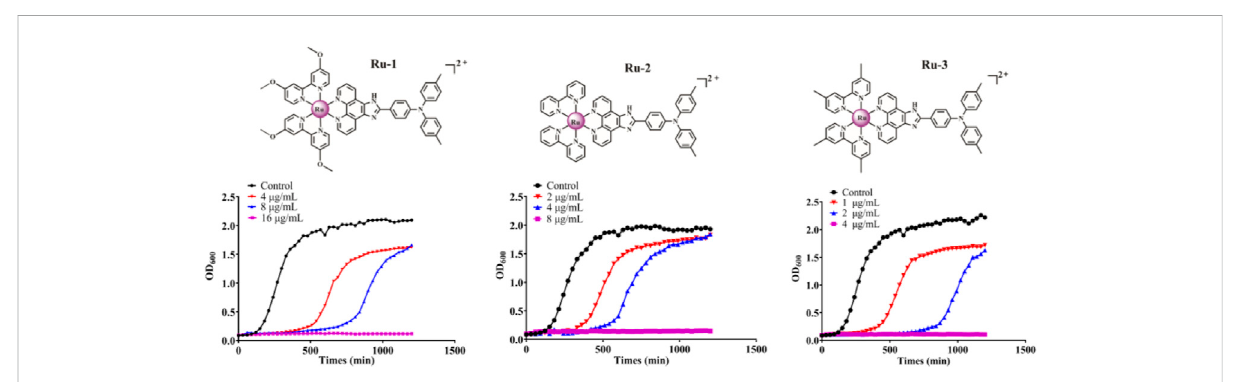
FIGURE 3 The inhibitory effect of Ru-1, Ru-2 and Ru-3 on Staphylococcus aureus . The bacterial culture was cultured in a plate reader at 37 ° C with orbit shaking at 180 rpm. The OD 600 was recorded at 30 min